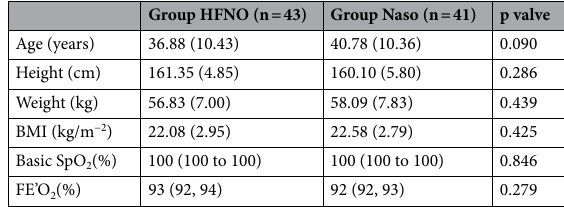
Table 1. Baseline characteristics of included patients. Data are presented as mean ± SDs or mean